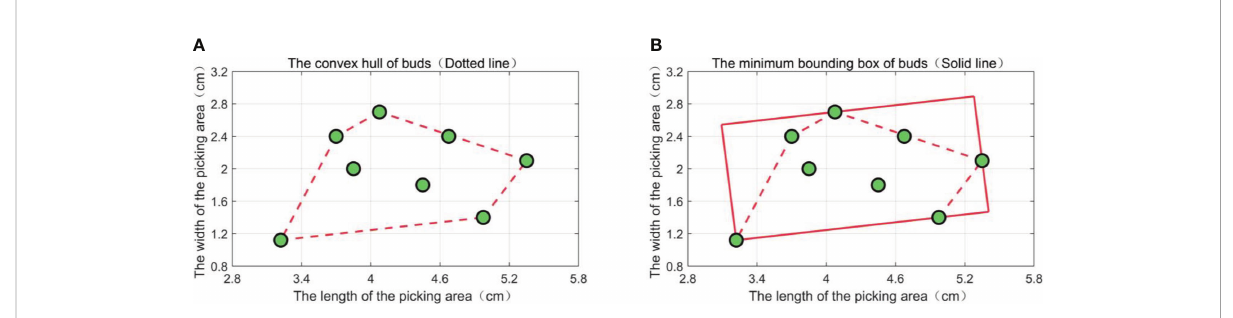
FIGURE 10 Convex hull of the bud set and its minimum bounding box. (A) A diagram of the convex hull of a point set. (B) A diagram of the minimum bounding box of a point